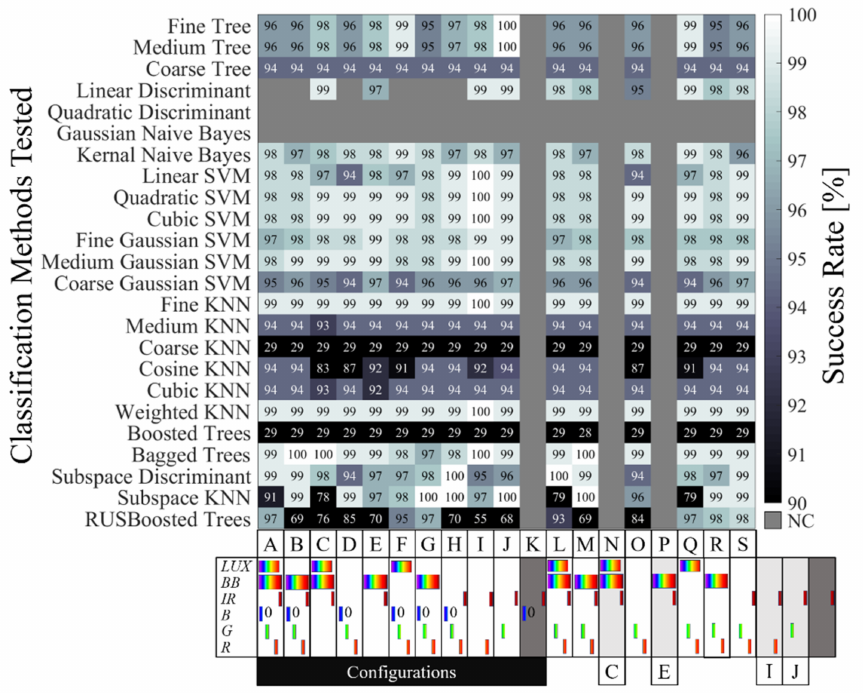
Figure 7. Performance of different classifiers trained through a 5-fold cross validation process with the B